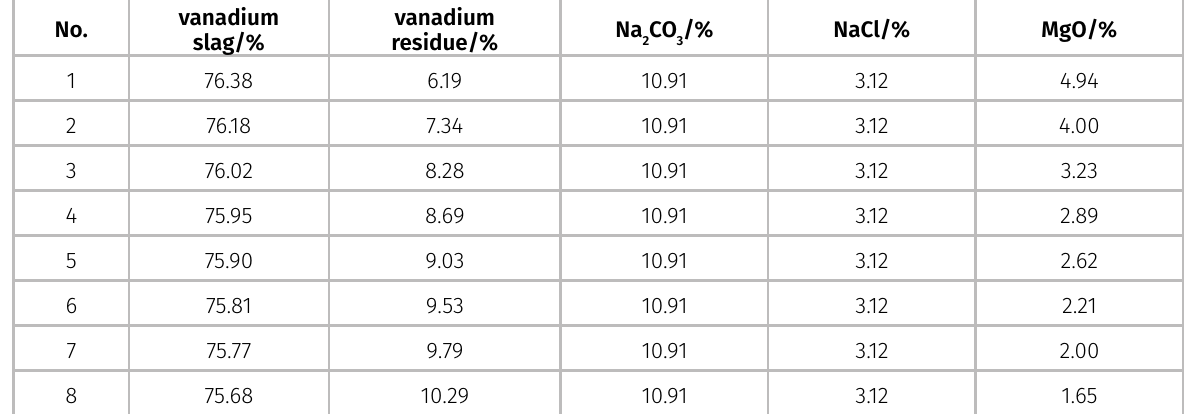
Table III. Experimental schemes for the effects of MgO on vanadium conversion.